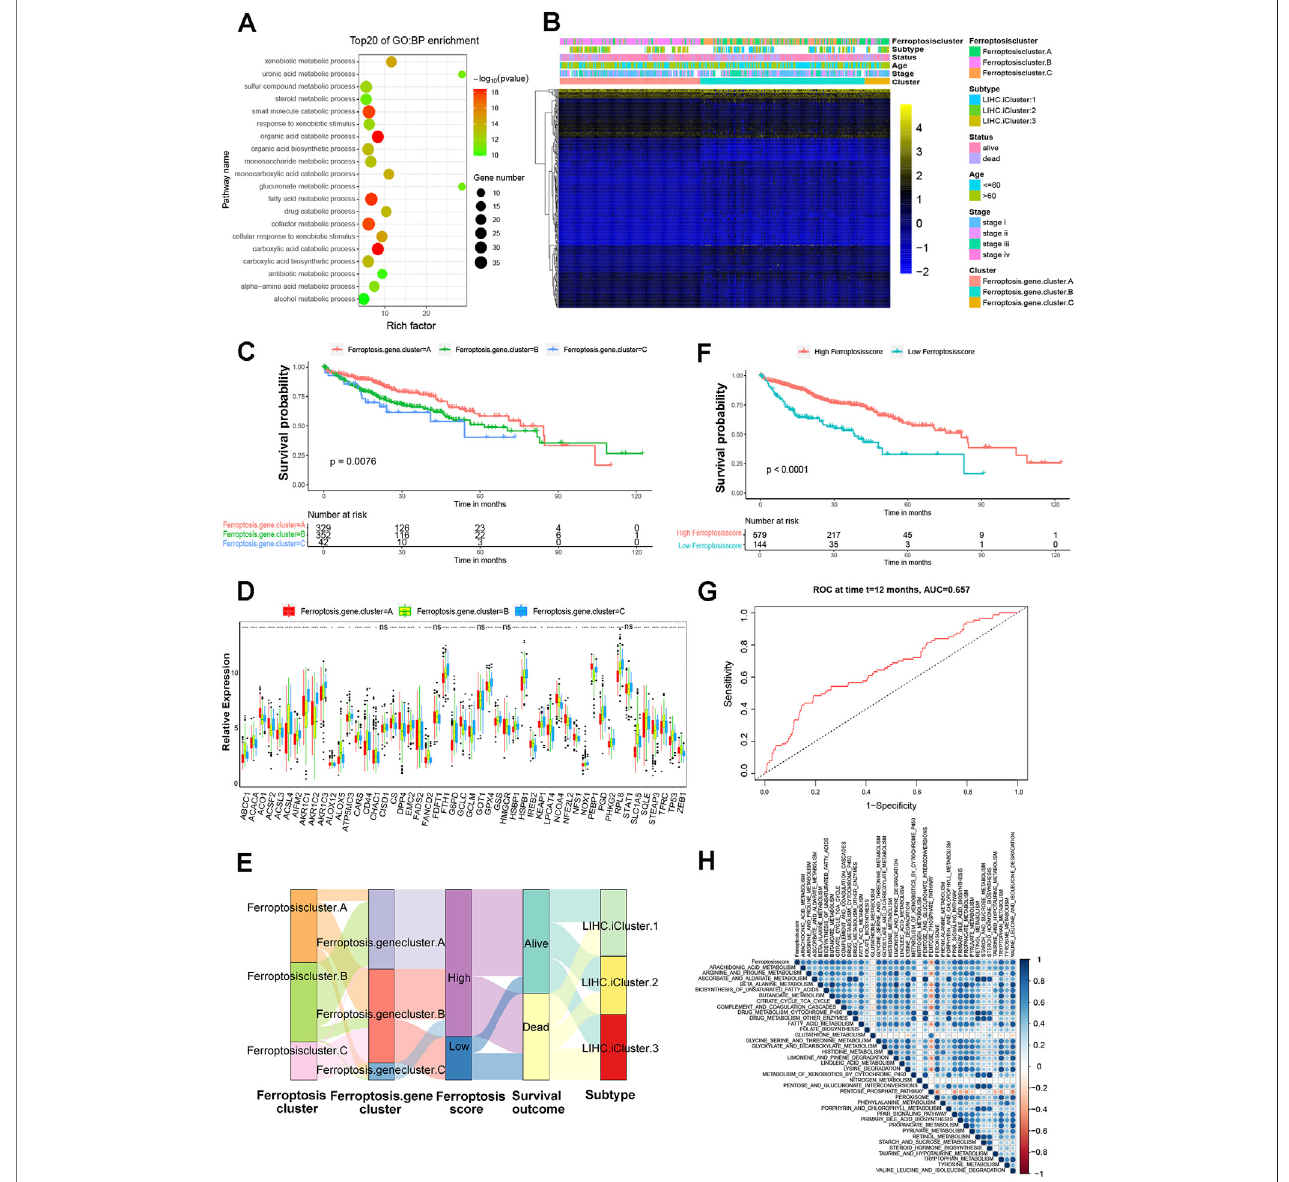
FIGURE 4 | Construction of ferroptosis signatures. (A) Functional annotation for ferroptosis related genes using GO enrichment analysis. (B) Unsupervised clusteringofoverlappingferroptosisphenotype-related DEGstoclassifypatientsintodifferentgenomicsubtypes,termedasferroptosisgenecluster-A,ferroptosisgene cluster-B and ferroptosis gene cluster-C, respectively. The gene signature subtypes, ferroptosis clusters, molecular subtypes, tumor stage, status, and age were used as patient annotations. (C) The survival curves of the ferroptosis phenotype-related gene signatures were indicated by the Kaplan-Meier curves ( p = 0.0076, Log- rank test). (D) The expression of 51 ferroptosis regulators in three gene cluster. The asterisks represented the statistical p value (* p < 0.05; ** p < 0.01; *** p < 0.001). (E) Alluvial diagram showing the changes of ferroptosis clusters, LIHC molecular subtypes, ferroptosis gene cluster and ferroptosis score. (F) Kaplan-Meier curves for high and low ferroptosis score groups in HCC patients. Log-rank test, p < 0.001. (G) ROC curves to verify the prediction advantage of ferroptosisSig score in HCC patients. AUC = 0.657. (H) Correlations between ferroptosisSig score and the known biological gene signatures using Spearman analysis. The negative correlation was marked with red and positive correlation with